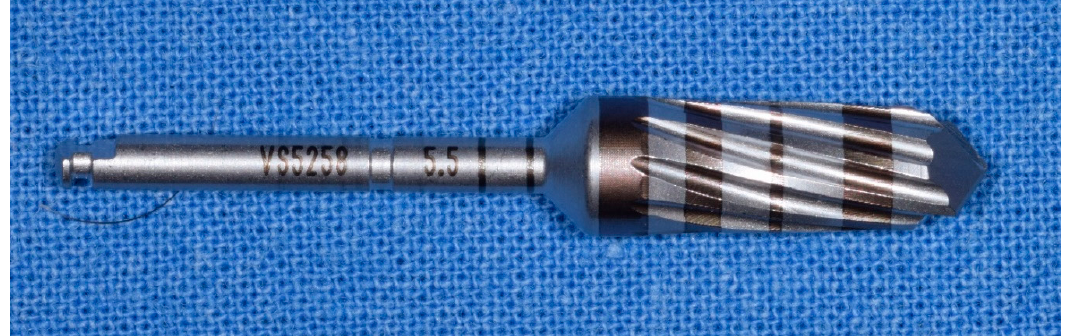
Figure 11. The 13th and last cutter with a diameter of 5.5 mm, method “implant drilling with bone compaction instrumen- tation technique.”